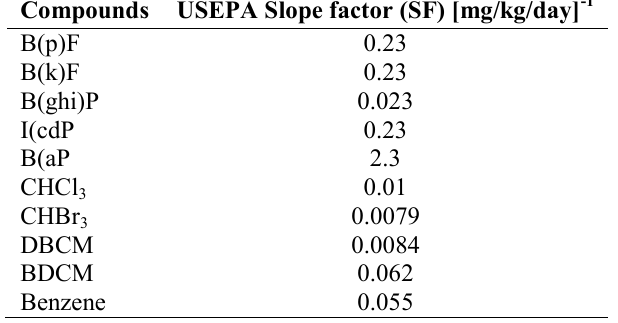
Table 8. Human health toxicological data for PAHs, THMs and benzene 14